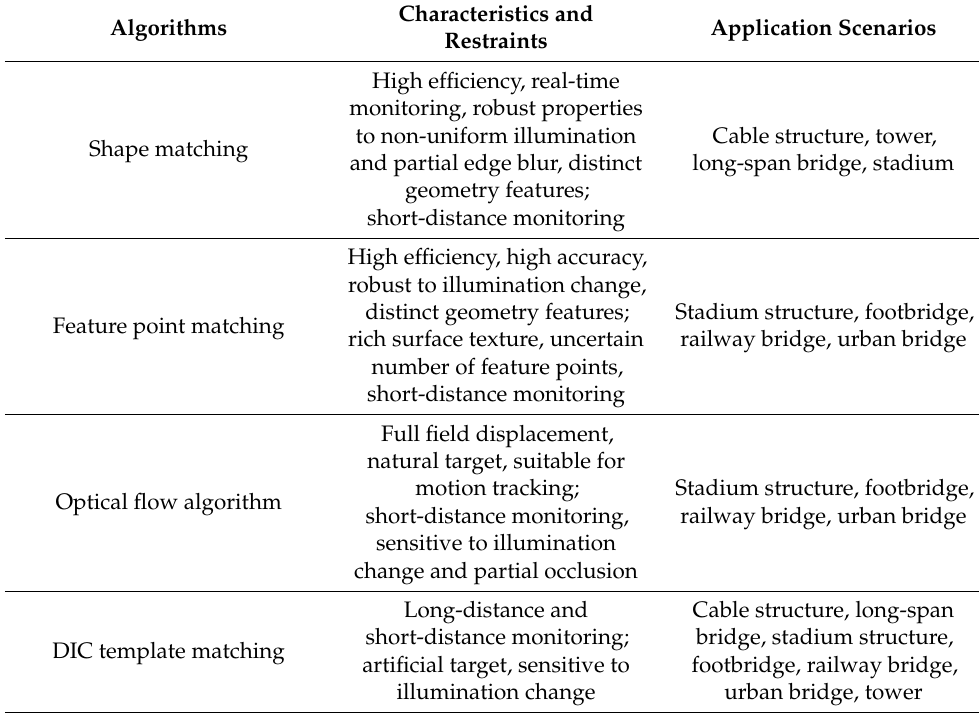
Table 1. Characteristics, limitations and application scenarios of the proposed tracking